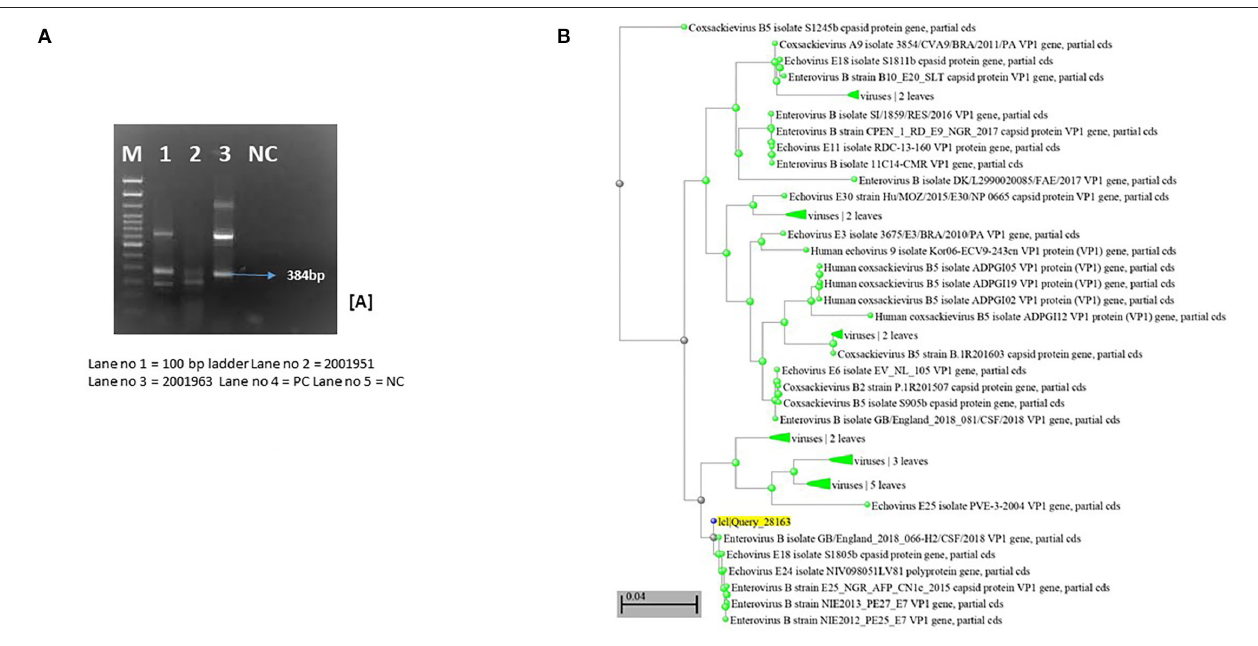
FIGURE 1 | Molecular characterization of Enterovirus strains based on PCR and sequencing. (A) Nested PCR amplification of VP1 region of enterovirus. (B) Phylogenetic analysis of Enterovirus strains based on VP1 identified in cases. Study strains are highlighted in yellow. Scale indicates genetic distance.